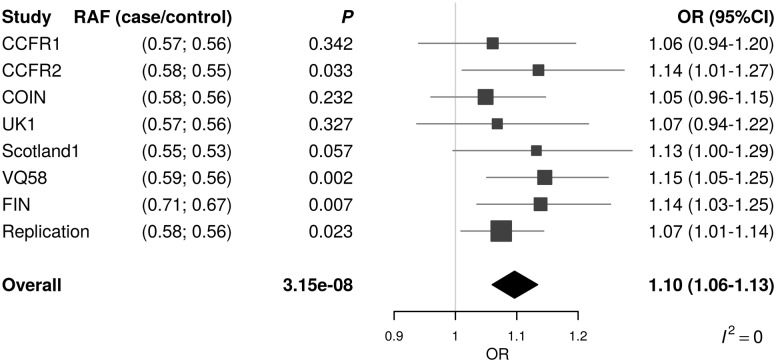
Forest plot of the odds ratios for the association between rs992157 and CRC. Studies were weighted according to the inverse of the variance of the log of the OR. Horizontal lines: 95% confidence intervals (95% CI). Box: OR point estimate; its area is proportional to the weight of the study. Diamond: overall summary estimate, with confidence interval given by its width. Vertical line: null value (OR = 1.0).